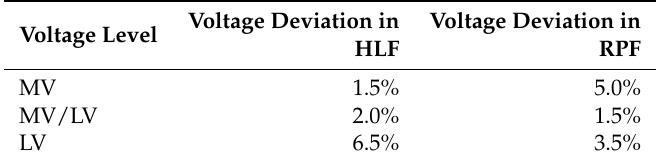
Table 4. Allowed voltage deviations used to identify voltage issues